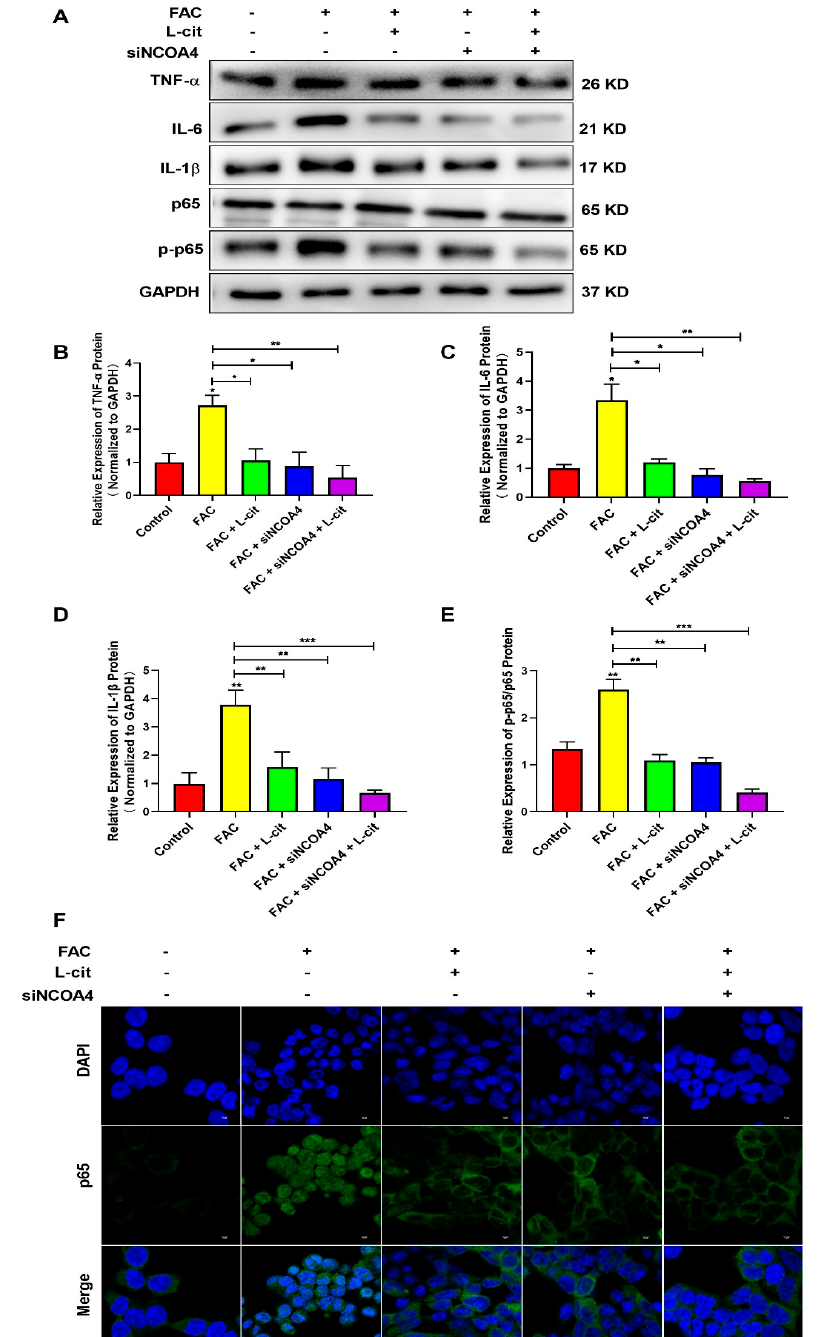
Figure 9. L-cit restrains ferritinophagy-mediated ferroptosis to alleviate inflammation in mTEC1 cells. The mTEC1 cells were transfected with 50 nM siNCOA4, followed by 2 mM L-cit, and treated with 200 µ M FAC for 24 h. Immunoblot analyses were explored. ( A , B ) Immunoblot analyses of TNF- α . ( A , C ) Immunoblot analyses of IL-6. ( A , D ) Immunoblot analyses of IL-1 β . ( A , E ) Immunoblot analyses of p-p65/p65. ( F ) Detection of p65 nuclear translocation using immunofluorescence assay. GAPDH was used as the loading control. Values represent mean ± SEM. of three independent experiments. Significant differences are represented by * p < 0.05, ** p < 0.01, *** p <